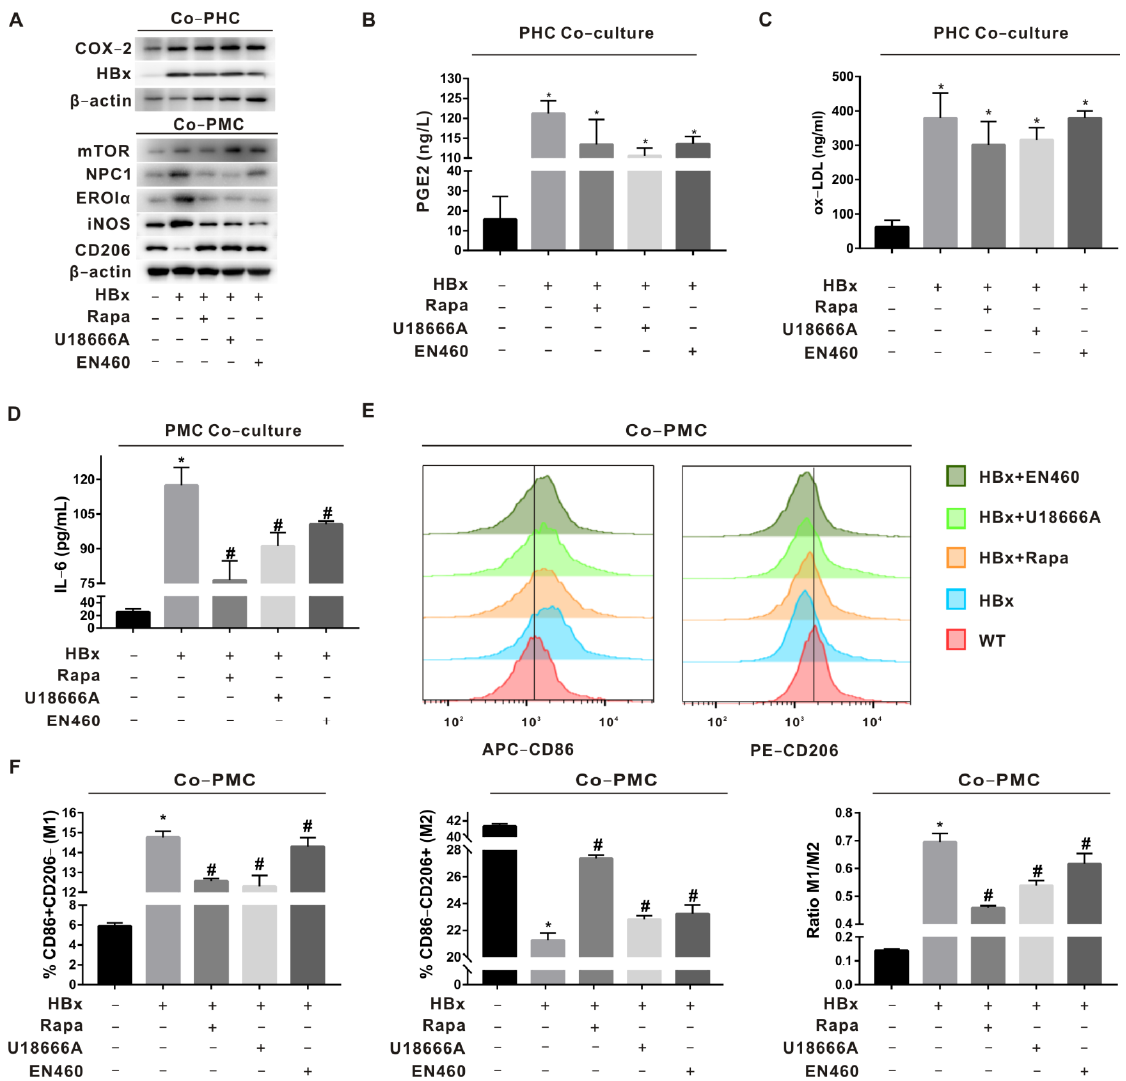
Figure 3. Regulation of macrophage polarization by the mTOR-NPC1-ERO1 α pathway was verified in HBx-Tg mouse ex vivo assay. Primary hepatocytes (PHCs) and primary macrophages (PMCs) were co-cultured by HBx-Tg mouse liver perfusion isolation. Rapamycin (Rapa), U18666A, and EN460 were used to establish the inhibition of mTOR, NPC1, and ERO1 α in PMCs. ( A ) WB detection of HBx and COX-2 protein levels in PHCs; mTOR, NPC1, ERO1 α , and polarization marker protein levels in PMCs. ( B – D ) ELISA detection of PGE2 levels ( B ), ox-LDL levels ( C ), and IL-6 levels ( D ) in the supernatant. ( E ) Flow cytometry detection of M1/M2-polarized phenotypes. ( F ) Quantitative analysis of M1(CD86)/M2(CD206) polarization. The data are presented as the mean ± SD. * p < 0.05, compared with the WT group. # p < 0.05, compared with the HBx group.